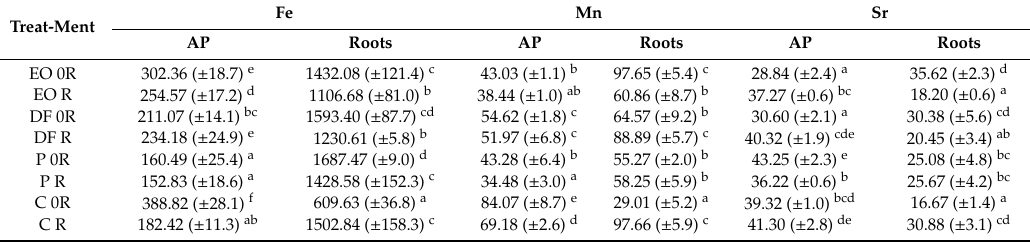
Table 7. The e ff ect of petroleum-derived substances and bioremediation on the content of iron, manganese and strontium in the aboveground parts (AP) and roots of Vicia faba L. (mg kg − 1 ). Treat-Ment